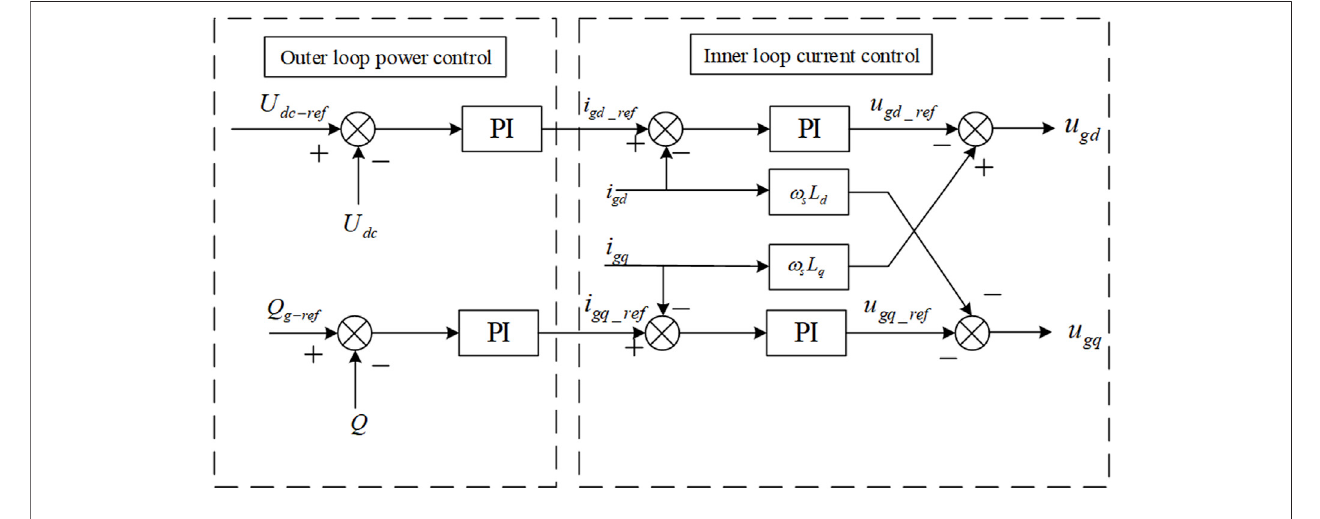
FIGURE 5 | Control block diagram of the grid side